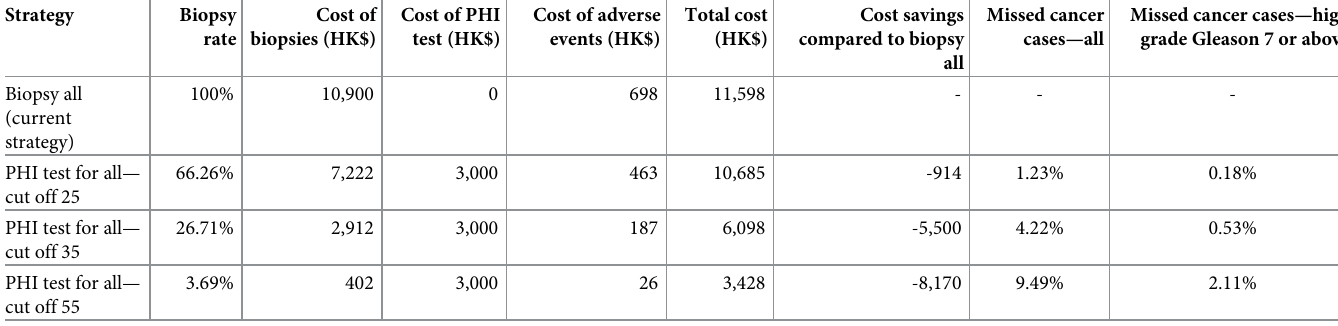
Table 2. Cost-consequence analysis of alternative diagnostic strategies. Strategy Biopsy